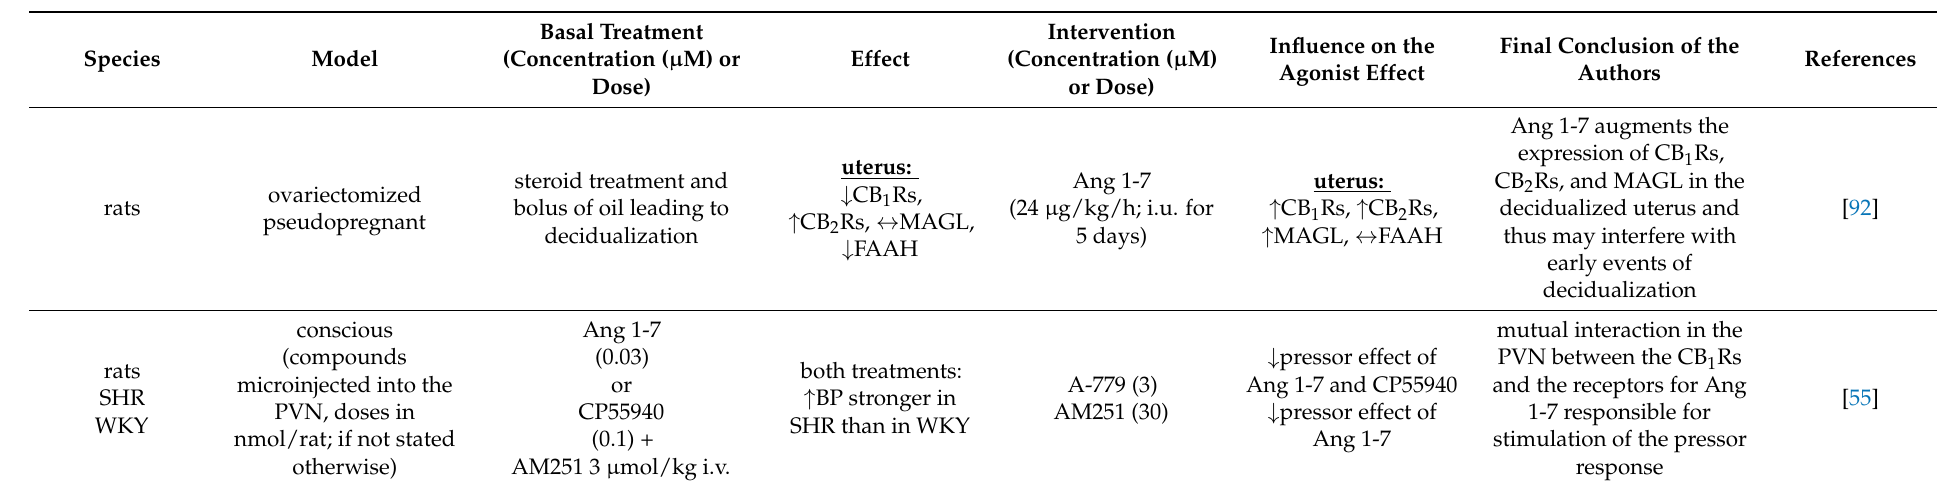
Table 3. Examples of the cross-talk between the (endo)cannabinoid and angiotensin